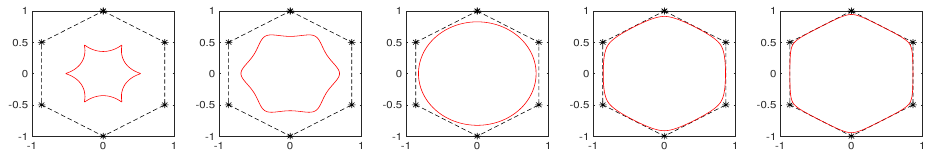
Figure 1. Curves generated by the scheme { S a k } k ≥ 0 with ( v 0 , β ) = ( − 0.6,2.1 ) , ( − 0.4,1.9 ) , ( cos ( π /3 ) ,0 ) , ( 3,4 ) , ( 5,6 ) (from left to